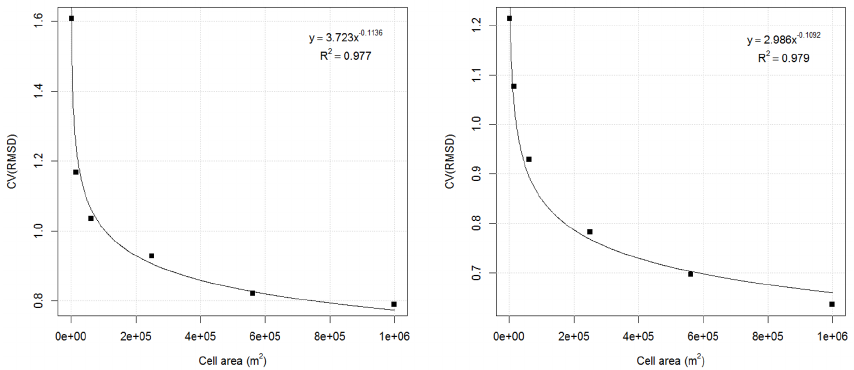
Figure 12. CV(RMSD) of the relative areas of one-storey (left) and two-storey (right) buildings, for six different levels of resolution of the grid (50m × 50m, 125m × 125m, 250m × 250m, 500m × 500m, 750m × 750m and 1000m × 1000m), in relation to the relative areas at municipality level, together with power law fits to the